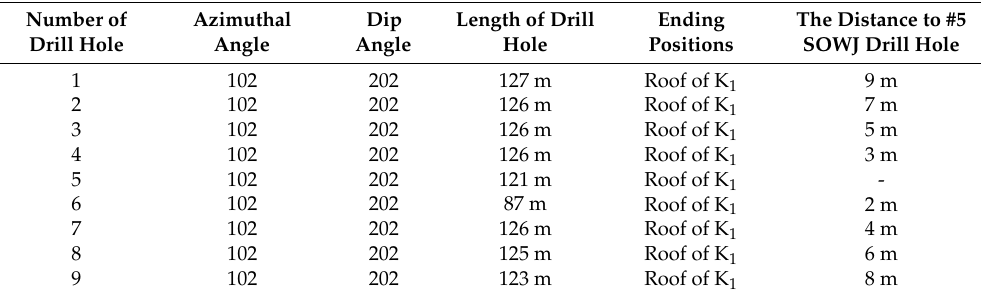
Figure 16. Layout of the drill holes. Table 5. Detailed parameters of the drill